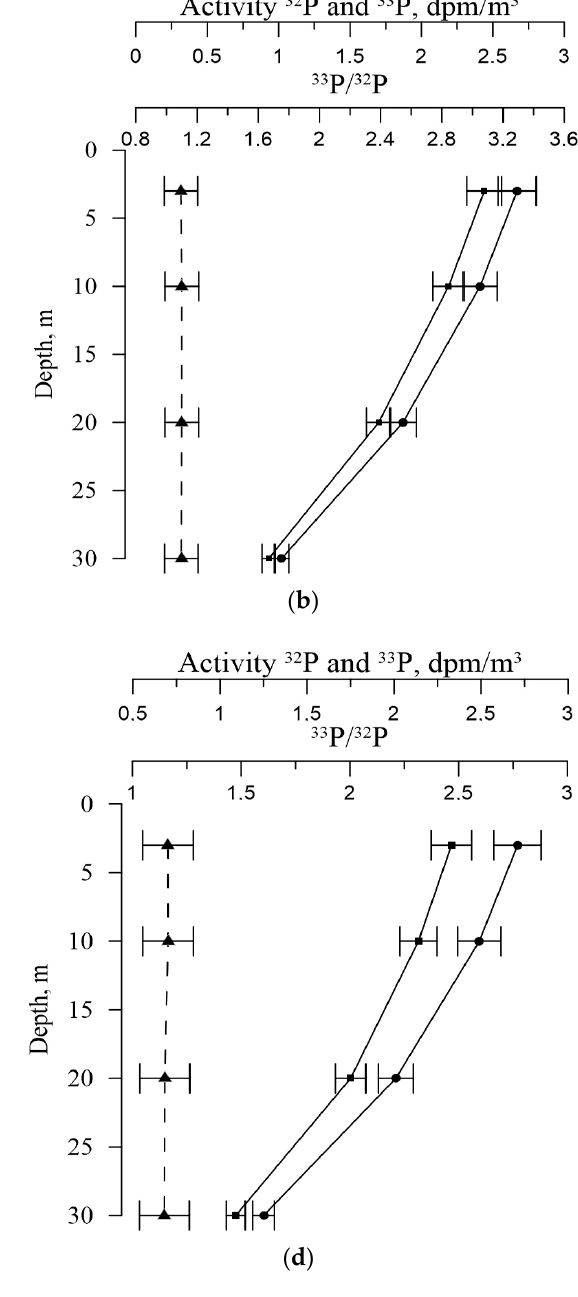
Figure 5. Values of 32 P and 33 P activity and 33 P/ 32 P ratio in seawater for different horizons: ( a ) winter